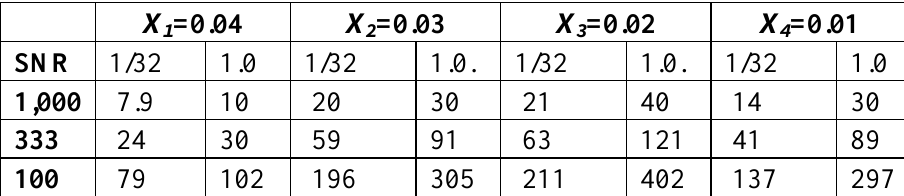
Table 2. The same that Table 1 but for spectral resolutions are 1/32 and 1.0 cm −1 and spectral regions are 6,200–6,206.5 and 6,200–6,400, respectively. The number of the spectral points N =